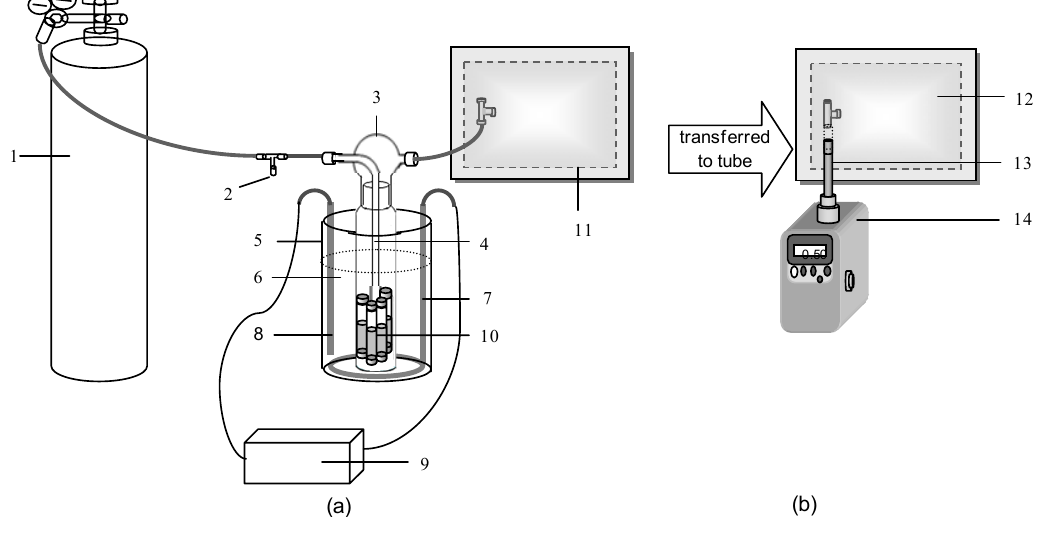
Figure 1. Illustration of ( a ) the sampling device for generating gaseous BTEX standards using an impinger system and ( b ) the secondary sampling system for transferring BTEX samples from the Tedlar bag into the sorbent tube for GC-FID determination.